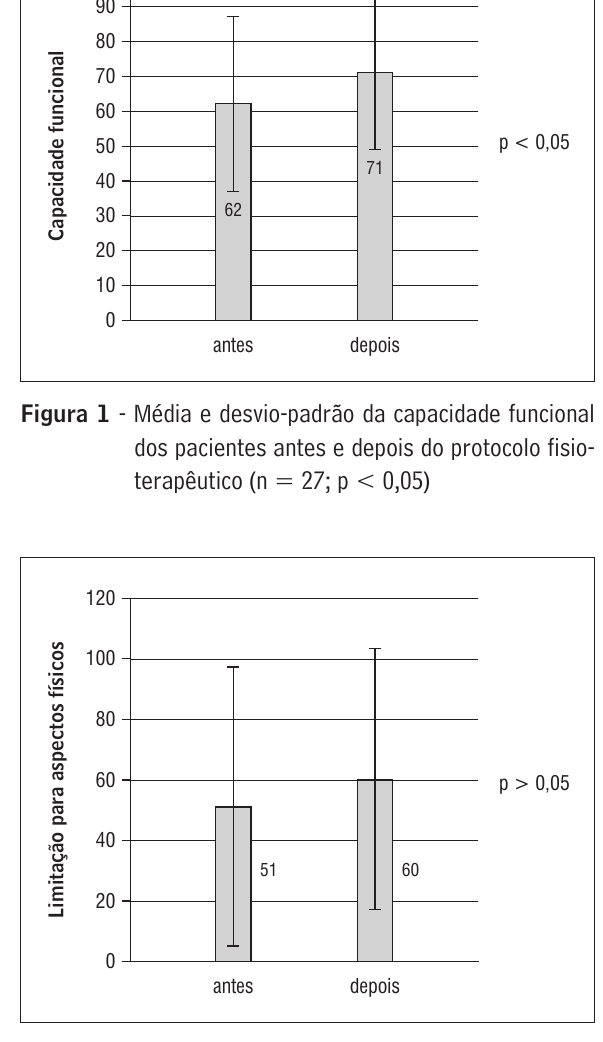
Figura 2 - Média e desvio-padrão da limitação por aspectos físicos dos pacientes antes e depois do protocolo fisioterapêutico (n = 27; p >